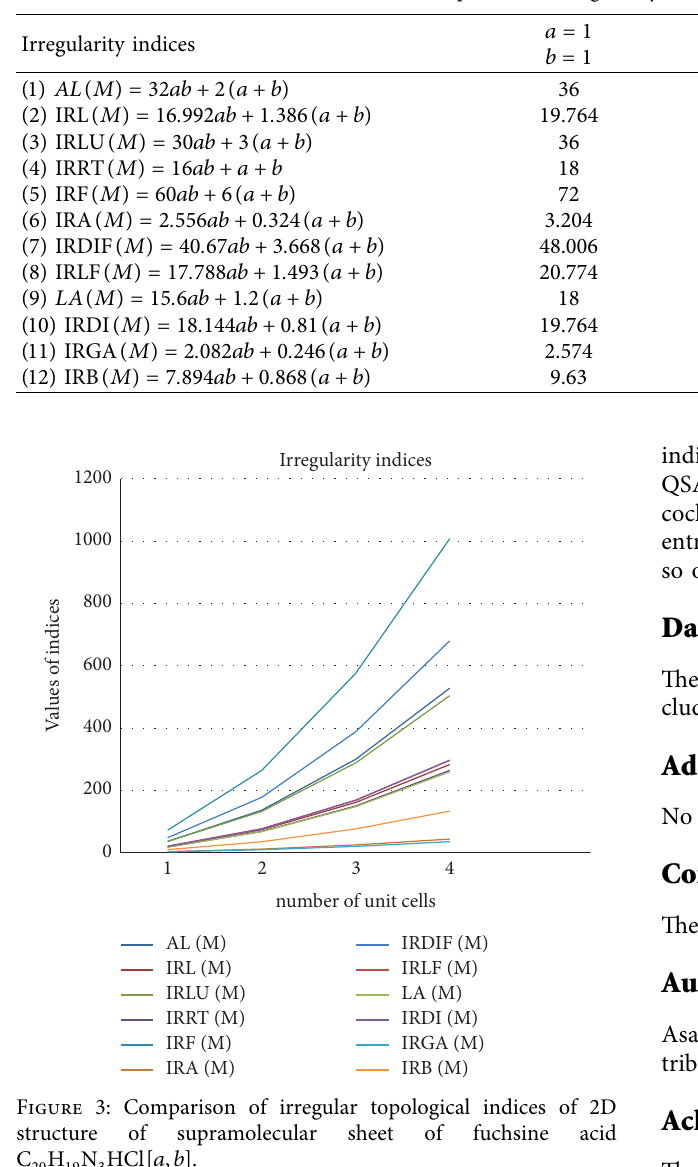
Table 2: Comparison of irregularity indices for C